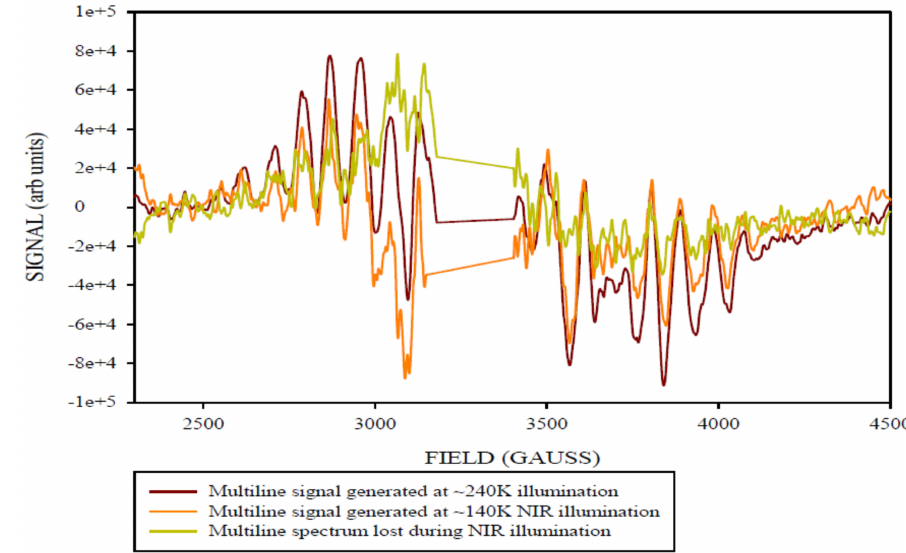
Figure 5. The X-band CW-EPR-generated ML signal obtained ( ≈ 240 K difference) minus ( ≈ 140 K NIR difference) spectra. This corresponds to the amount of ML signal lost ( ≈ 35%) when illuminating the sample at a lower temperature of ≈ 140 K using the NIR